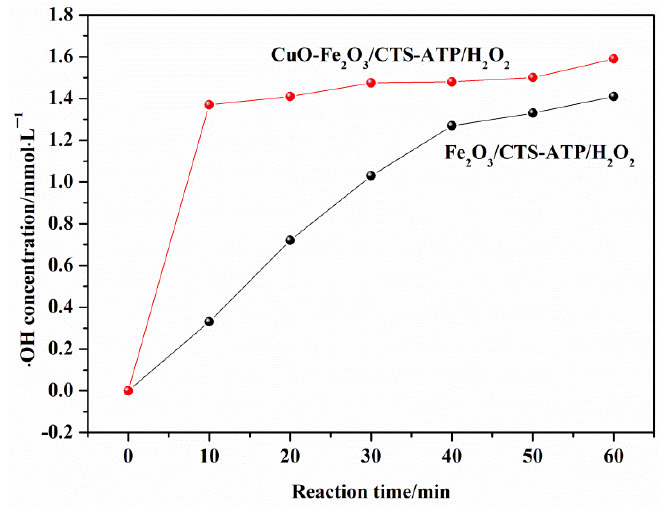
Figure 6. The trend of ·OH concentration in two systems with